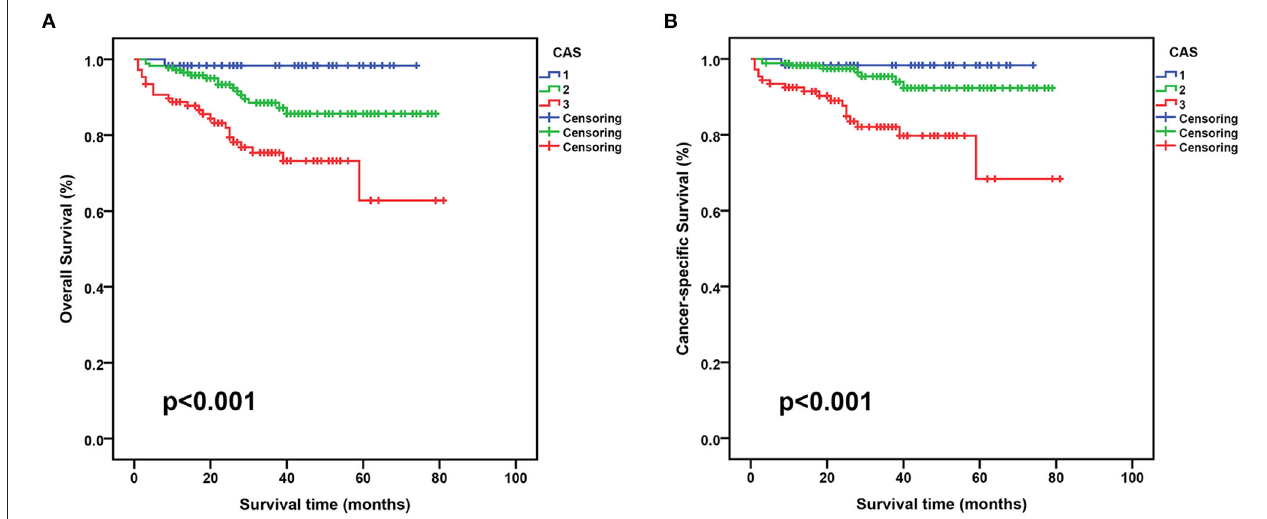
FIGURE 3 | Kaplan-Meier curves for OS and CSS stratified by CAS grade in the training set. (A) , CAS OS; (B) , CAS CSS. OS, overall survival; CSS, cancer-specific survival; CAS, combination of albumin-globulin score and sarcopenia.